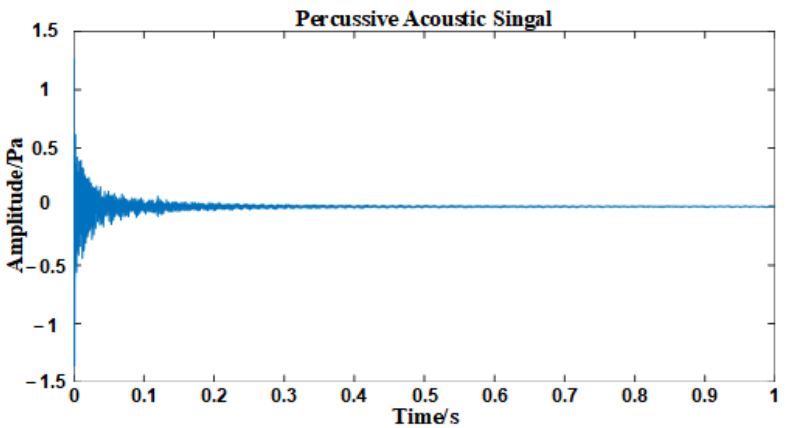
Table 3. Different experimental cases with different volume percentage of water.